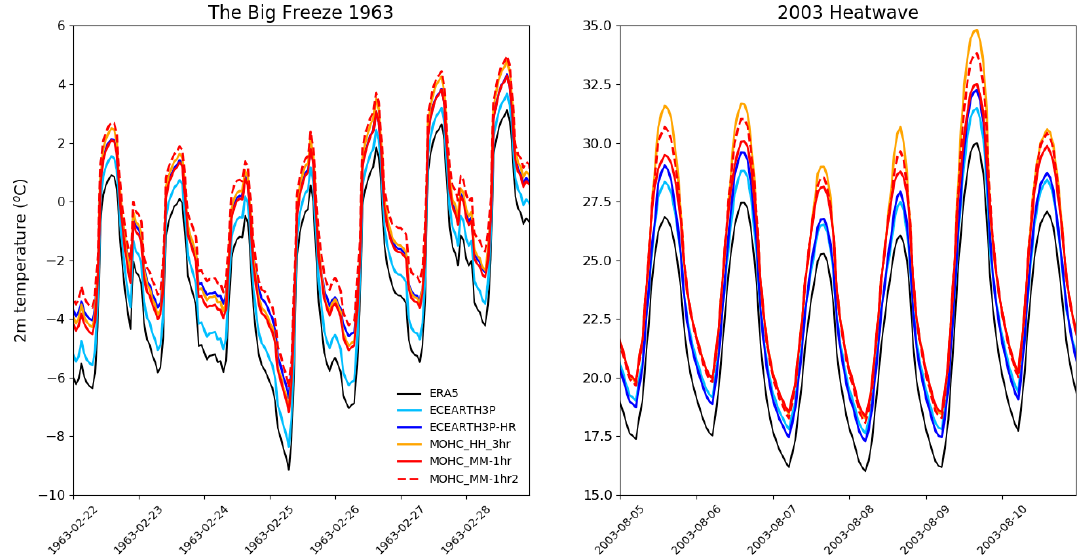
Figure 8. Top panels: two case study events showing the possible impacts of climate change on GB population-weighted 2m temperatures. ERA5 is shown in black, with delta-corrected model projections in colours. See Table 1 for further details of the models.